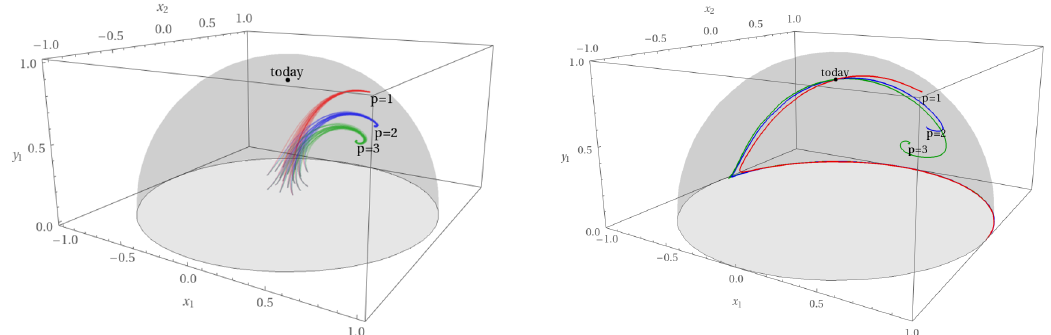
Figure 2 . Dynamical trajectories in the ( x 1 , x 2 , y 1 ) space for stringy models with k 1 and k 2 specified by (3.11). Left: initial condition are chosen to be matter domination. All trajectories start from the center of the hemisphere and approach the surface without going through the black dot. Right: all trajectories pass through the correct today’s values of late time observables. In this case all trajectories originate from kinetic domination initial